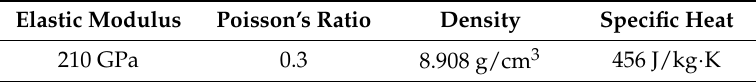
Table 4. Mechanical and physical properties of Ni-200 Alloy [34].